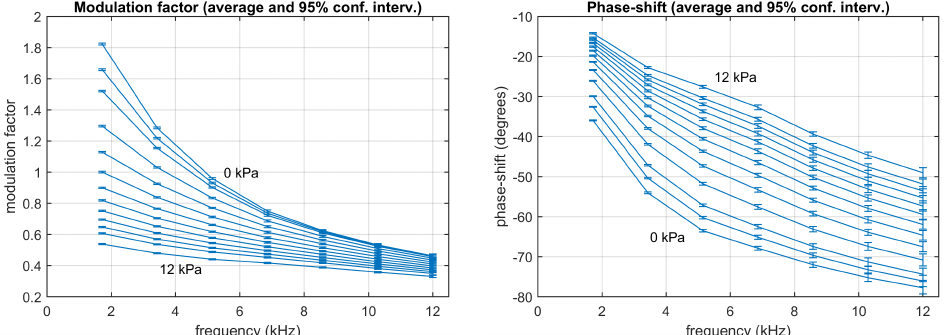
Figure 5. Experimental data: Modulation factor ( left ) and phase-shift ( right ) measured from the calibration partition for the harmonics 1st to 7th at the concentrations 0, 0.5, 1, 2, 3, 4, 5, 6, 7, 8, 9, 10, and 12 kPa. Each point represents the average using 125 measurements (the error bars represent the 95% confidence